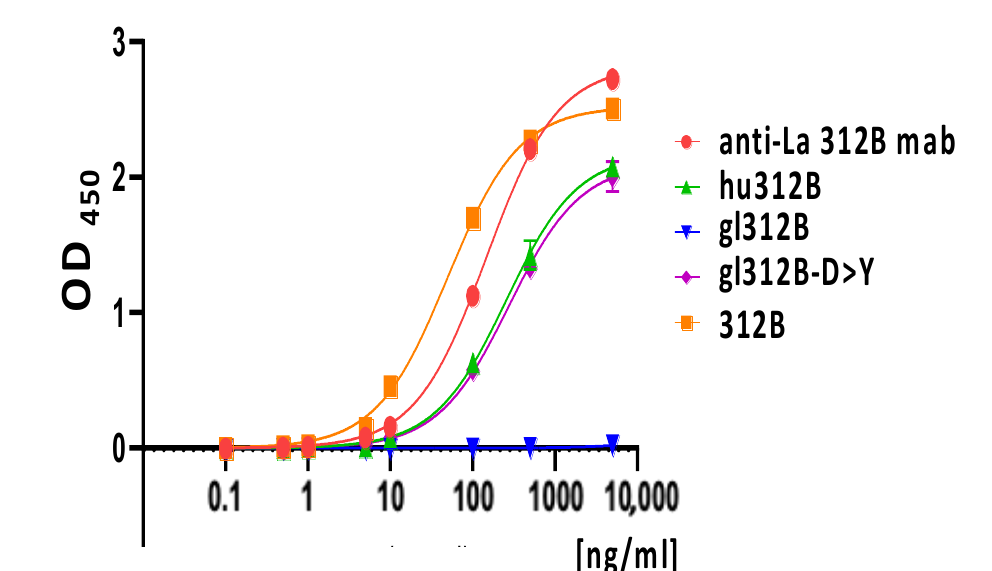
Figure 5. Comparison of the binding curves obtained by ELISA for the different 312B ab derivatives using the TCM-La protein as substrate. Increasing amounts of the respective ab were analyzed ranging from 0.1 to 5.000 ng/mL, including the anti-La mab as secreted from the hybridoma (anti-La 312B mab), the IgG4 construct of the humanized 312B ab (hu312B), the murine 312B ab (312B), the germline ab (gl312B), and the mutant in which the aspartate present in the V H germline sequence is replaced by a tyrosine residue (gl312B-D > Y). Each data point is the result of three estimations.